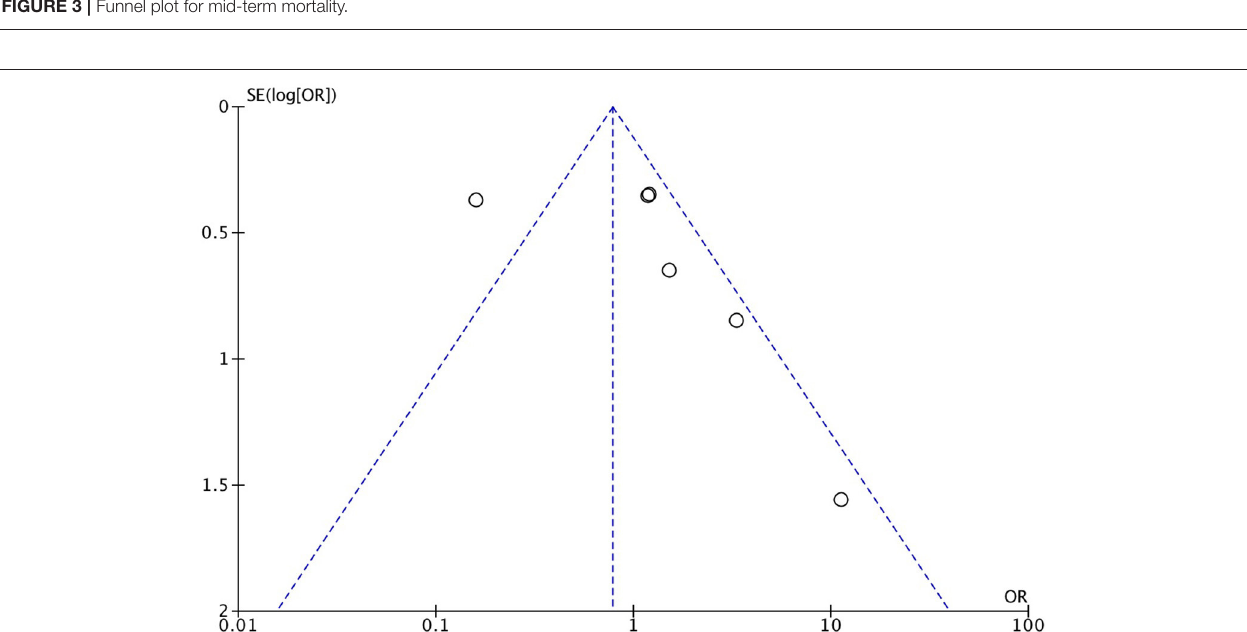
FIGURE 3 | Funnel plot for mid-term mortality.